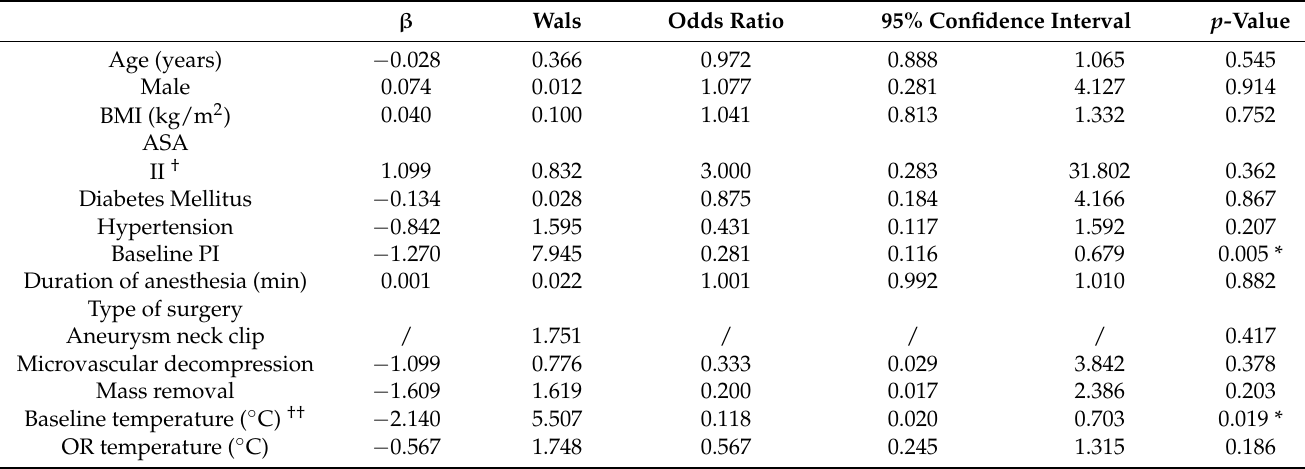
Figure 3. Comparison of core body temperatures between the normothermia group and the hy- pothermia group. Core body temperatures were significantly higher in the normothermia group at every moment. Data are expressed as mean ± standard deviation. Significant differences between the two groups at each point are indicated as * p < 0.05 or ** p < 0.01. Table 2. Univariate logistic regression analysis of intraoperative hypothermia.